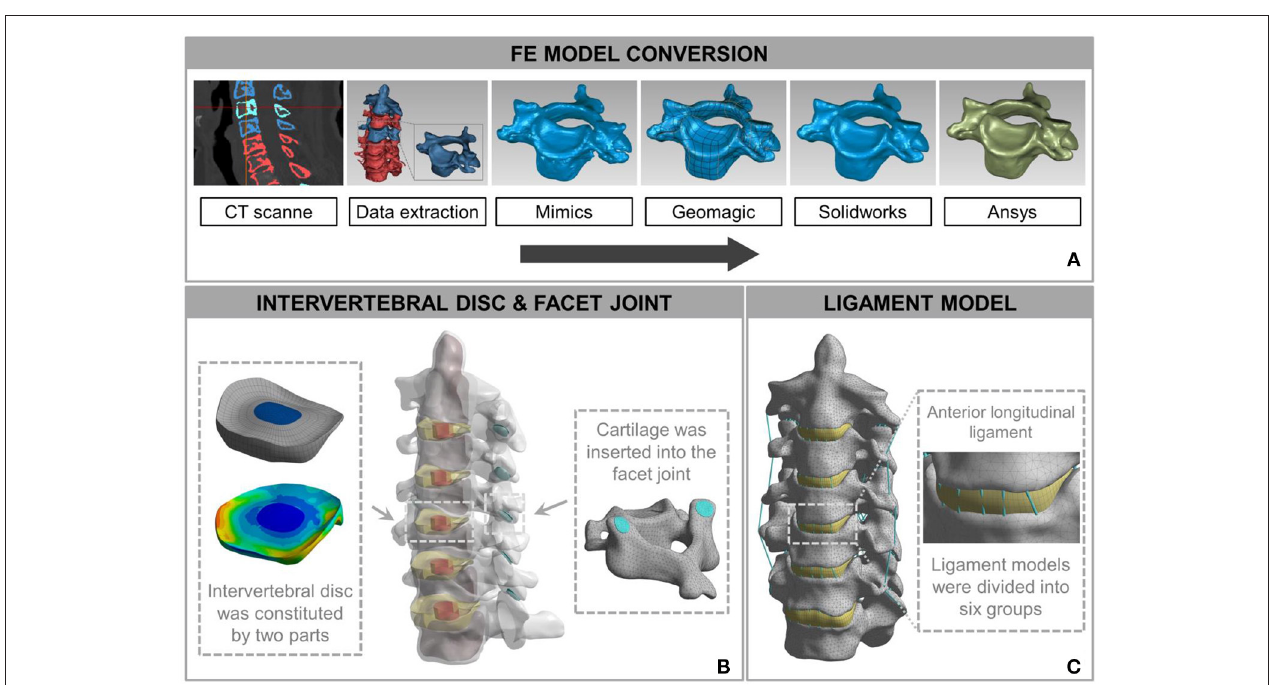
FIGURE 2 | Development and validation of intact finite element (FE) cervical spine model. (A) The conversion procedure for developing FE cervical vertebrae models included reconstructing a geometrical structure of vertebrae (Mimics 20.0), performing smooth operation (Geomagic 12), and supporting format conversion by computer-aided design (CAD) software (Solidworks 2015). Then, the output document was imported into FE software (Ansys Workbench 18.0) to build the cervical spine components. (B) A model consisting of a vertebra disc and an intervertebral disc was constructed by cartilage and intervertebral discs inserted into the facet joint and the intervertebral space. (C) The intact FE cervical spine model with ligament